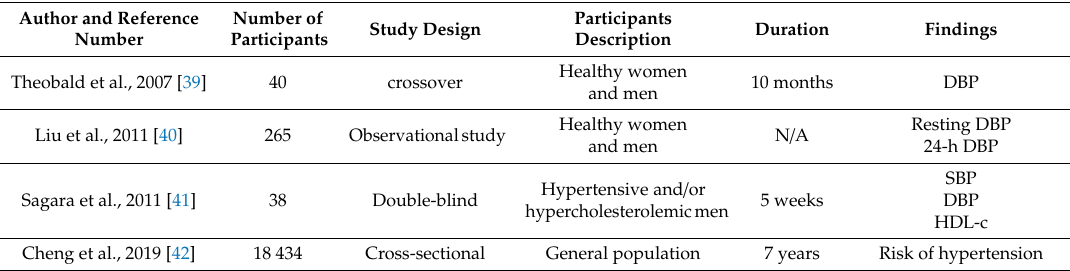
Table 3. Comparison of